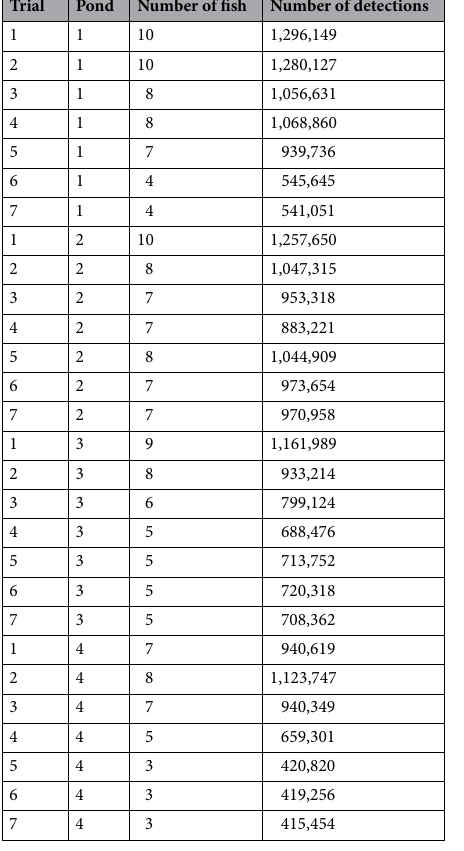
Table 1. Data set summary. Number of position detections in each trial and pond of our data